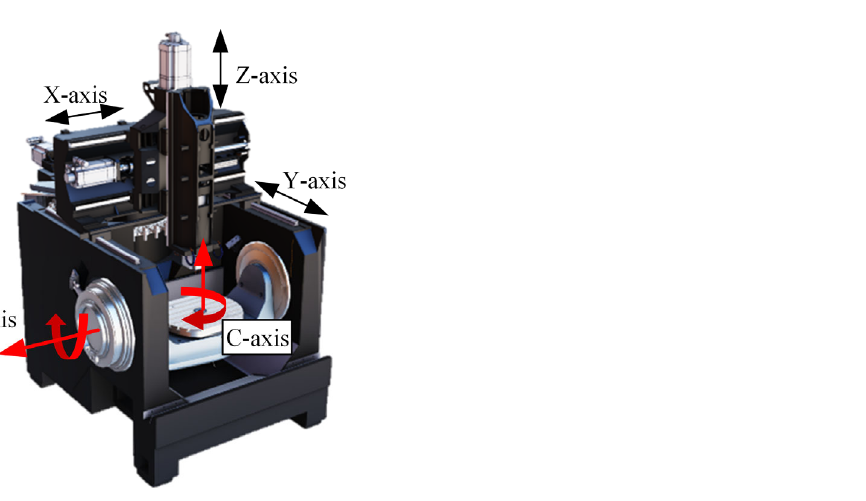
Figure 7. The structure of the five-axis machine tool used in the experiment.